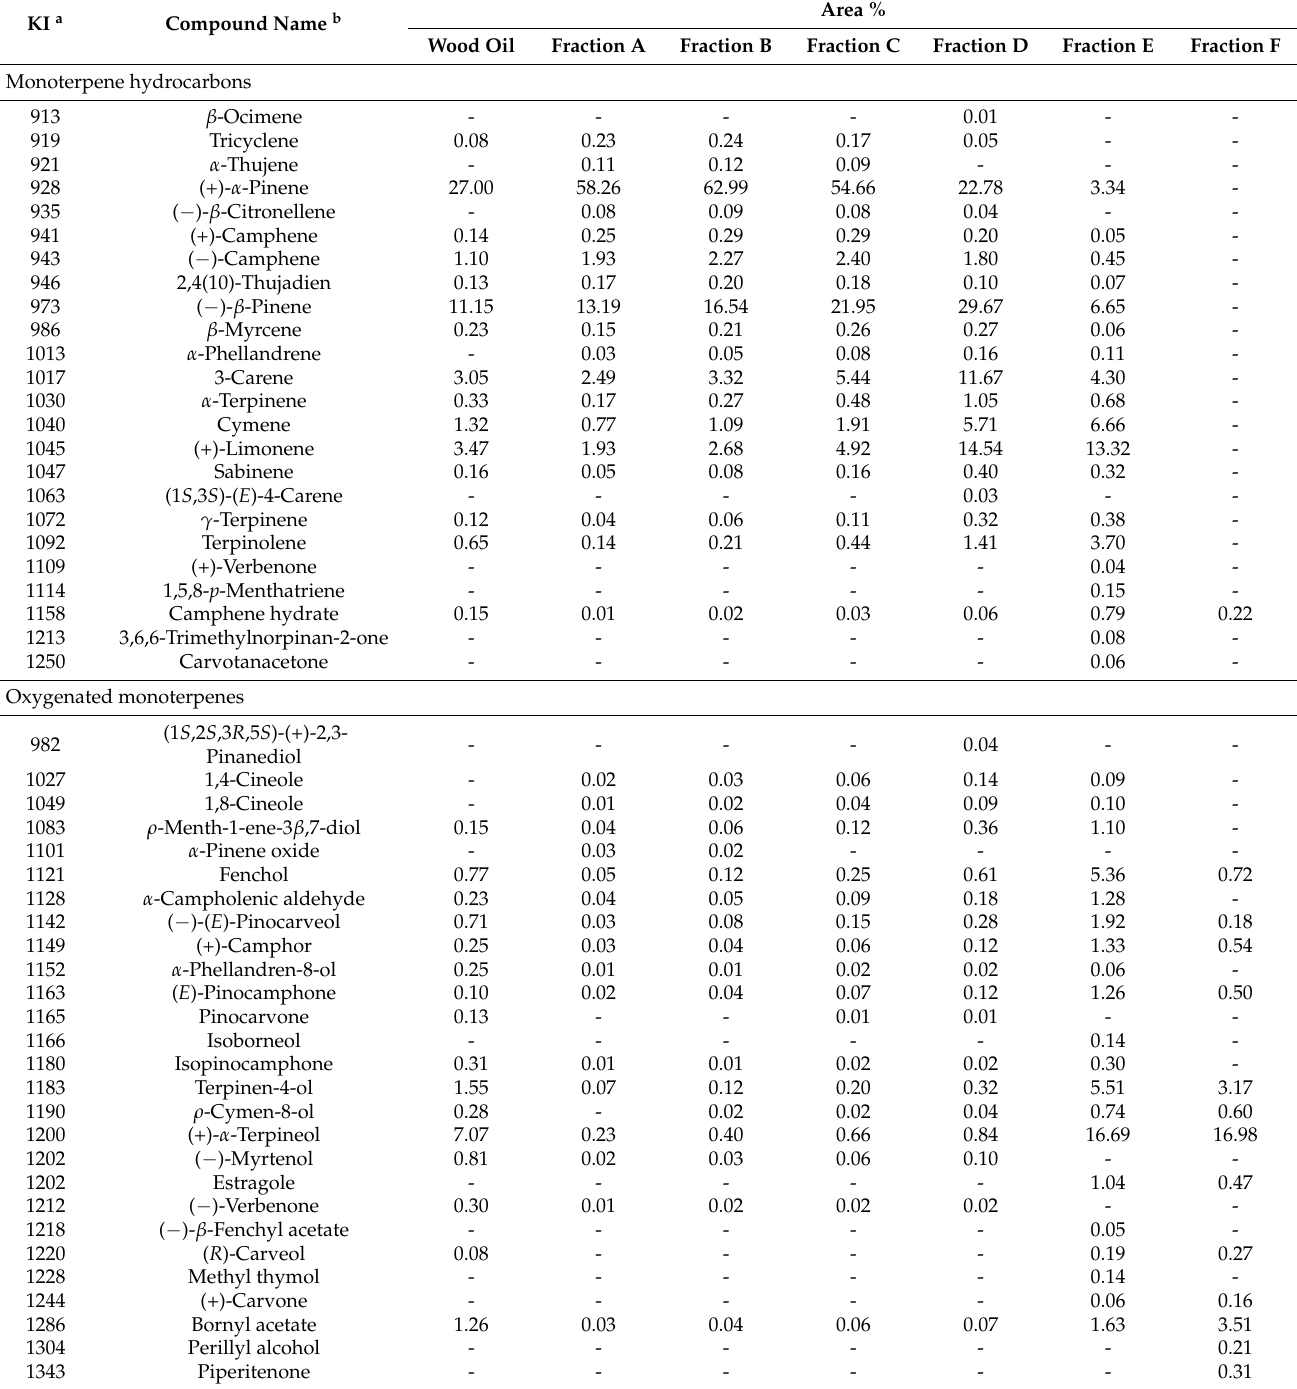
Table 5. Chemical compositions of six fractions identified by GC–MS